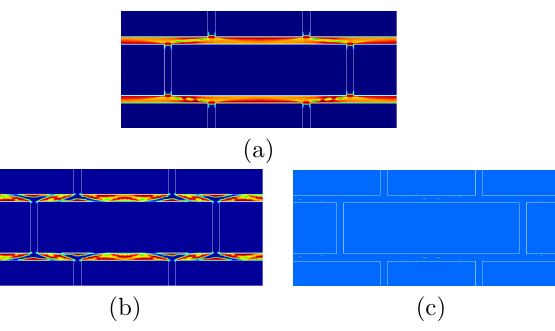
Figure 8. Damage pattern due to E pression): a) isotropic model, b) orthodam-11, c) orthodam-22.